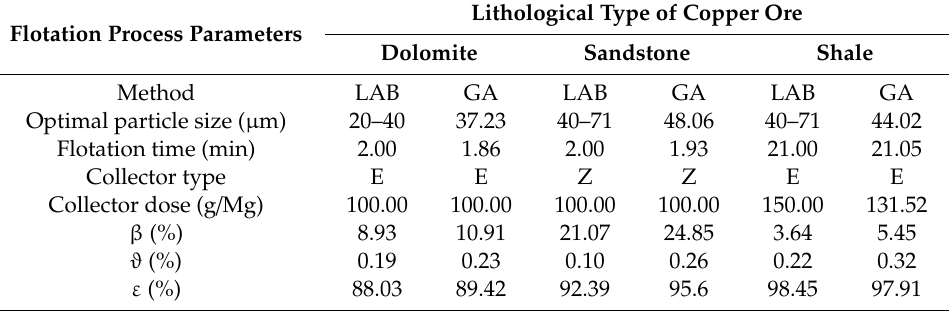
Table 15. The results obtained for the analysis of cases of all lithologic types separately in the Denver flotation machine.